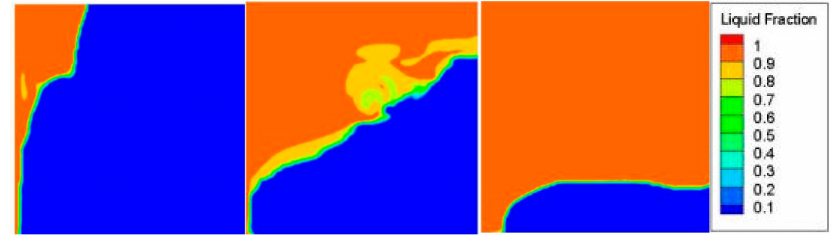
Figure 3. Para ffi n melting liquid rate diagram.